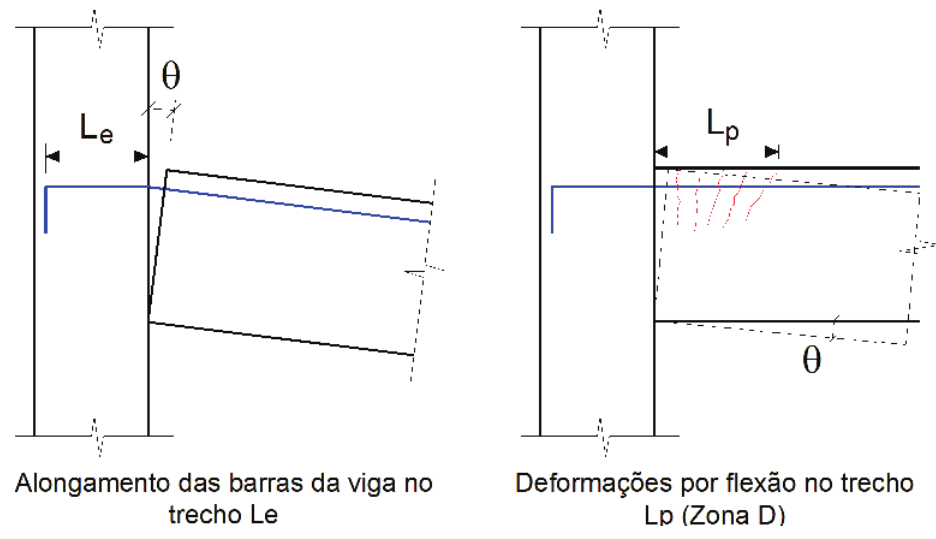
Mecanismos de deformações em ligações viga-pilar de extremidade